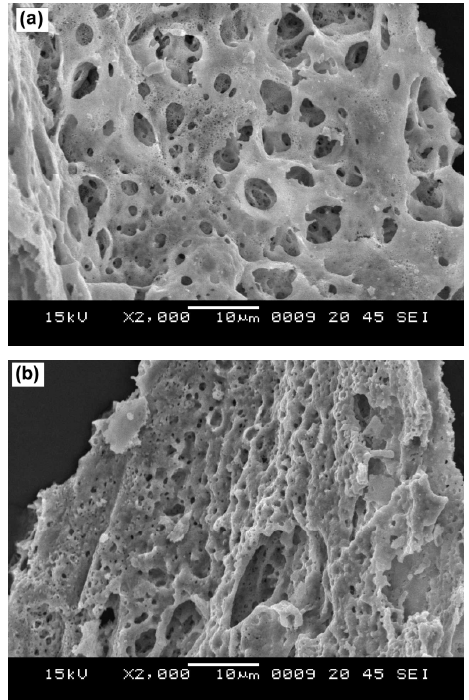
Fig. 7 A comparison of excitation spectra of Y 3  x Eu x Al 5 O 12 ( x = 1) and Y 3  x Eu x Al 5  y Si y O 12 ( x = y =